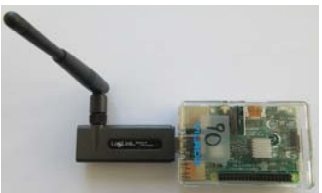
Figure 1. Raspberry Pi unit including an internal Wi-Fi card and